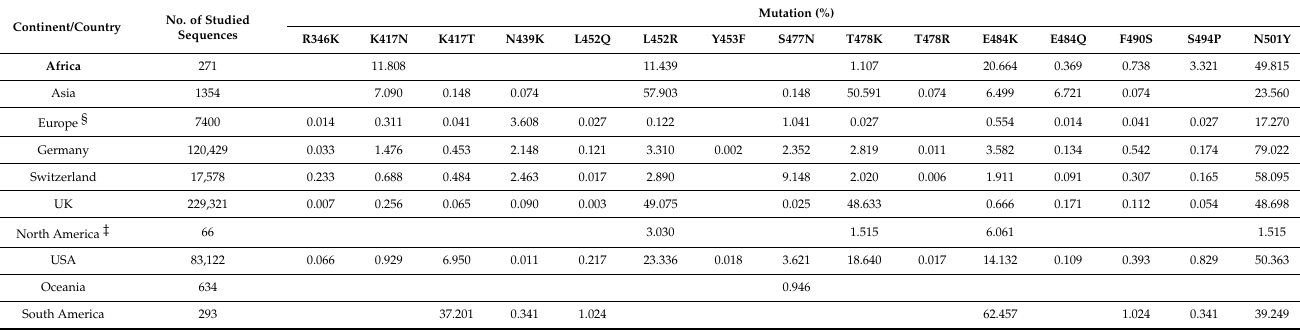
Figure 2. Global prevalence of adaptive and prolonged infections’ mutations in the receptor-binding domain (RBD) of the SARS-CoV-2 spike (S) protein from 30 May 2021 till 28 July 2021. ( A ) Bar graph showing the continent/country-wise distribution of SARS-CoV-2 sequences. For the percentage calculation, the total number of sequences ( n = 460,645) was used. § = Europe without Germany, Switzerland and the UK. ‡ = North America without the USA. ( B ) Bar graph showing the percentages (%) of the respective adaptive mutations. ( C ) Bar graph showing the percentages (%) of the respective prolonged infections’ mutations. Table 4. Continent/country-wise prevalence of adaptive mutations in the receptor-binding domain of the SARS-CoV-2 Scheme 30 May 2021 till 28 July 2021.